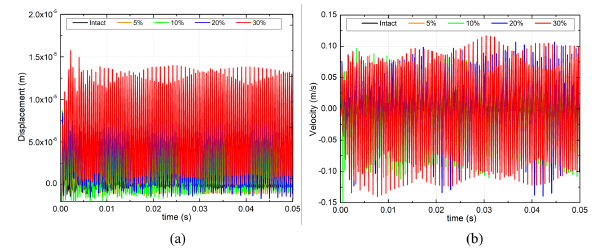
Figure 14: Dynamic response of frequency ratio η =2 between intact and debonded models a) displacement b) velocity.